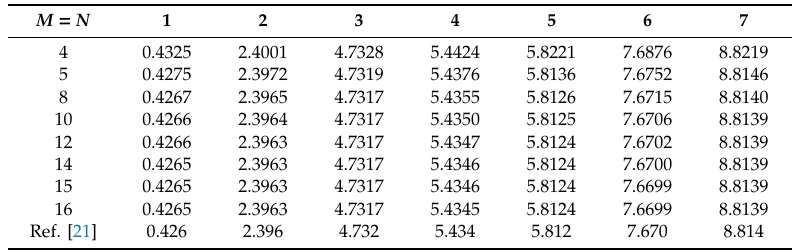
Table 3. Convergence study of frequency for rectangular laminated plates with SSFF .